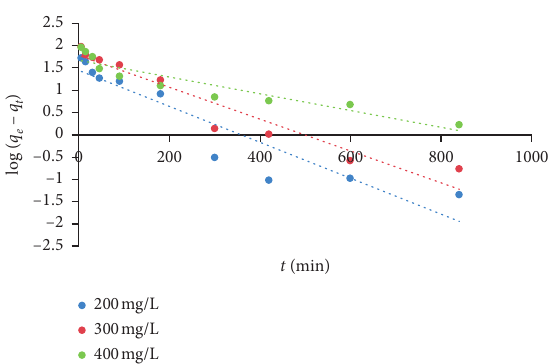
Figure 5: The first-order dynamic model for MnO